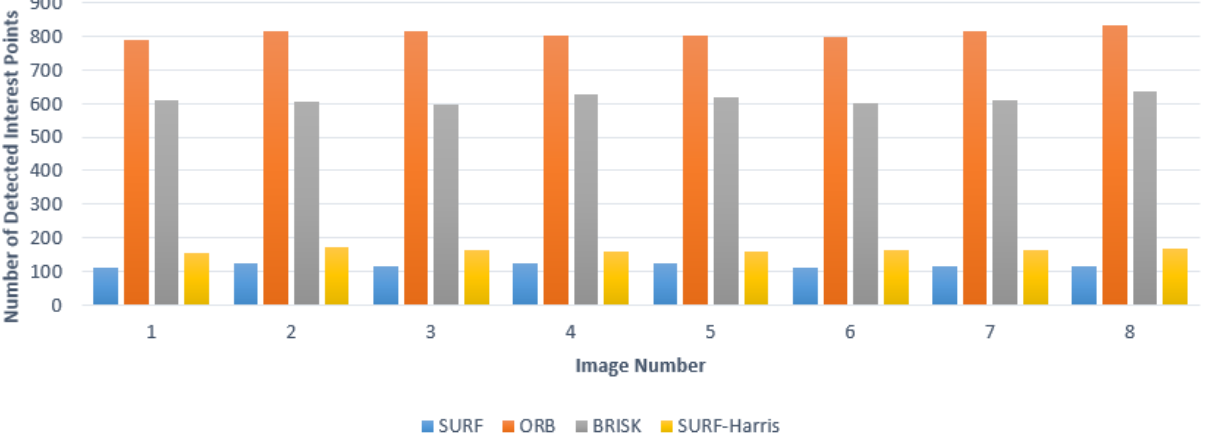
Figure 17. Total number of detected interest points by each algorithm in each image of dataset